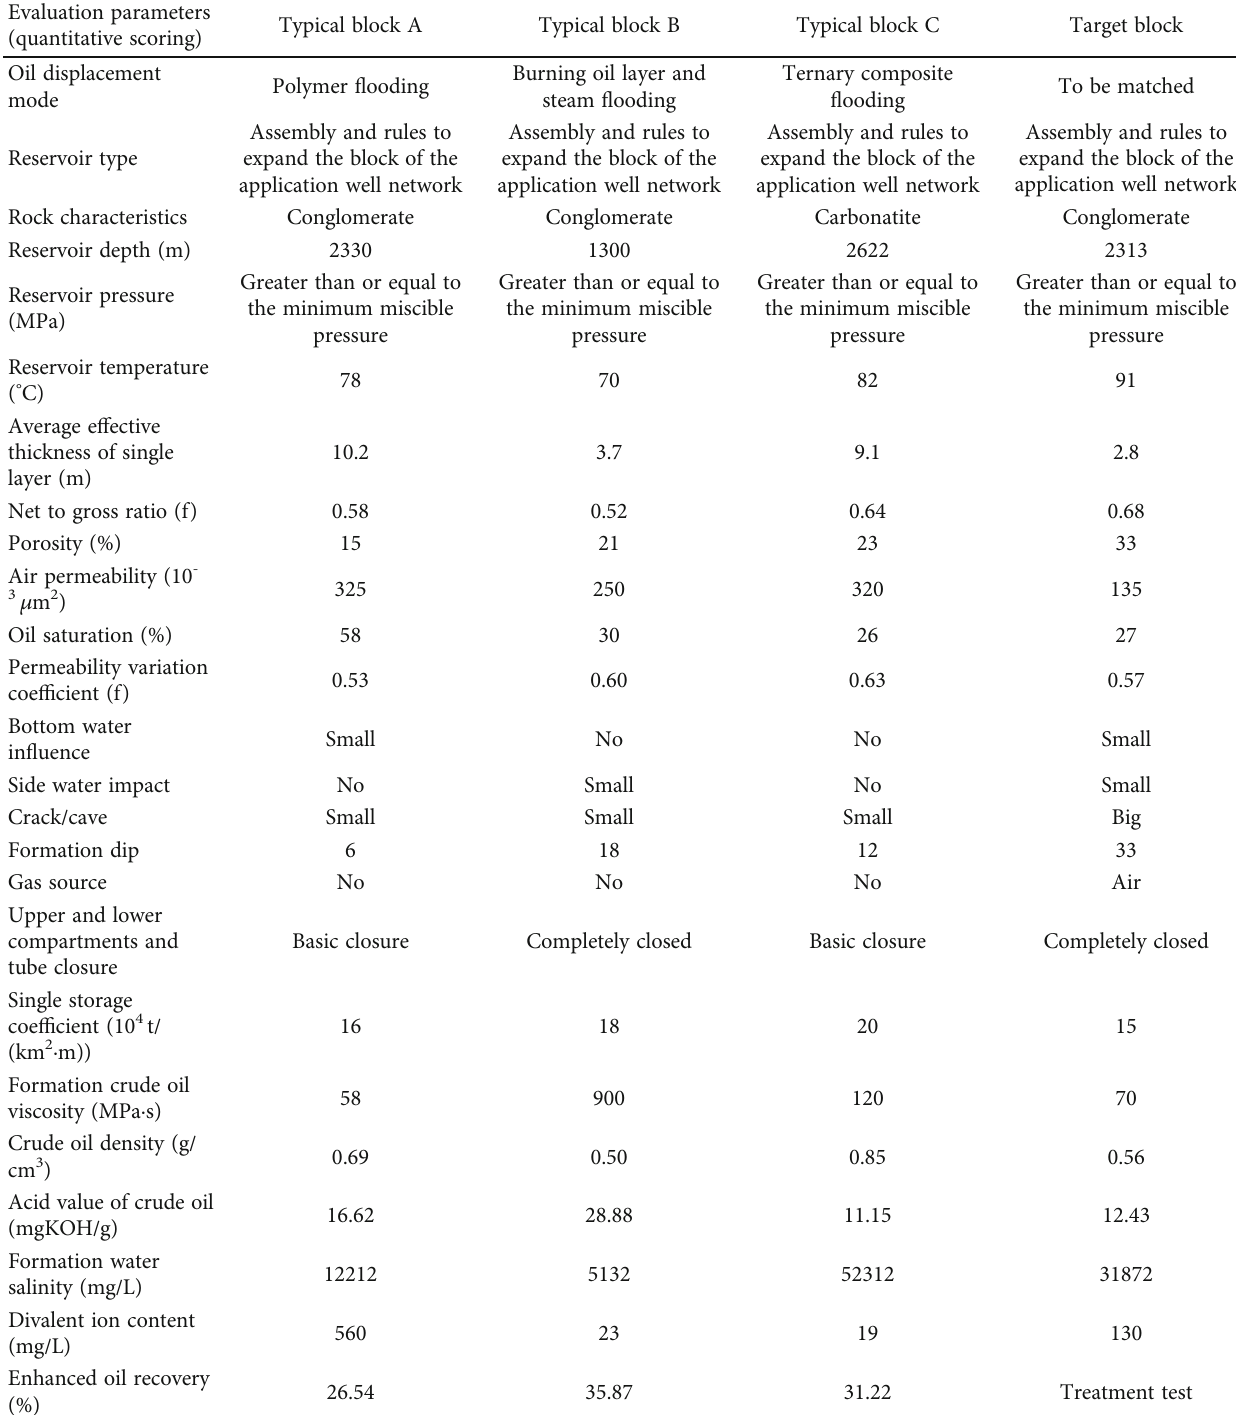
Table 2: Analytical data of